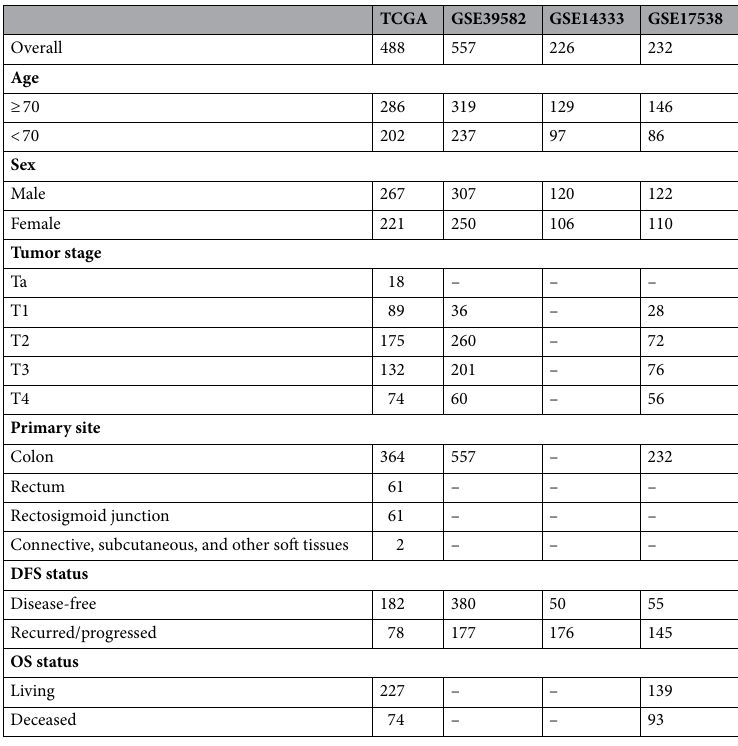
Table 1. Summary of the clinicopathological characteristics of four independent colorectal cancer datasets. DFS disease-free survival, OS overall